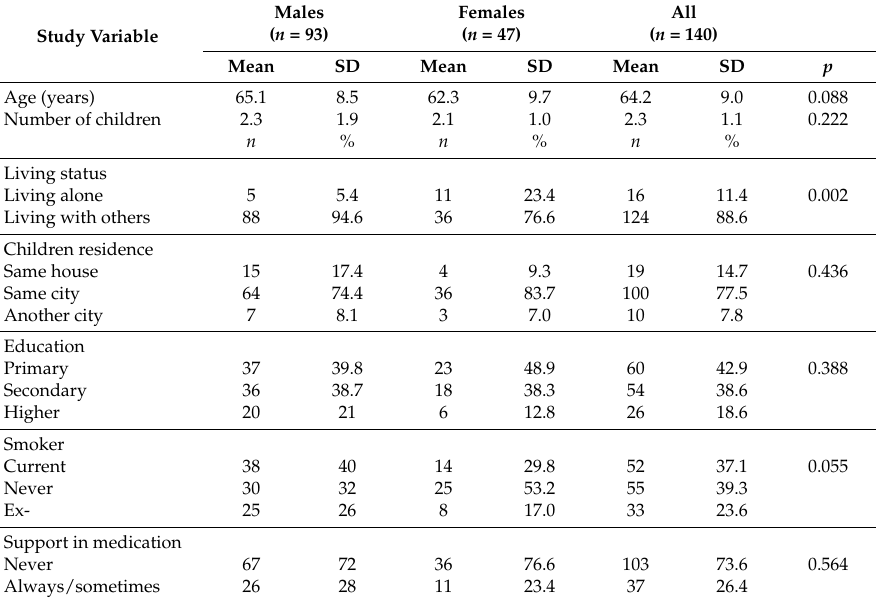
Table 1. Patients